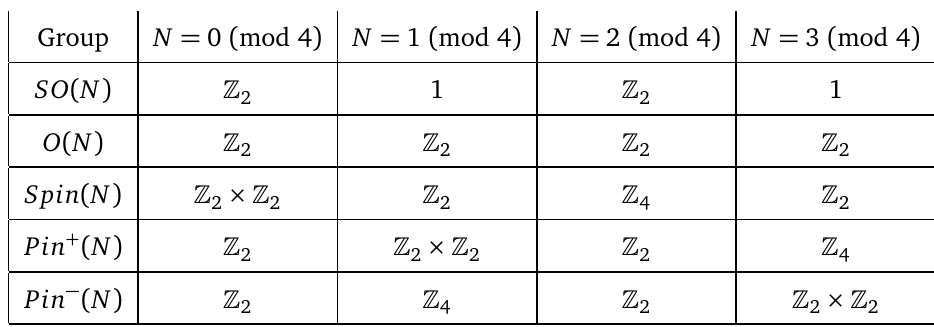
Table 3: Centers of the Gauge Groups ( N >